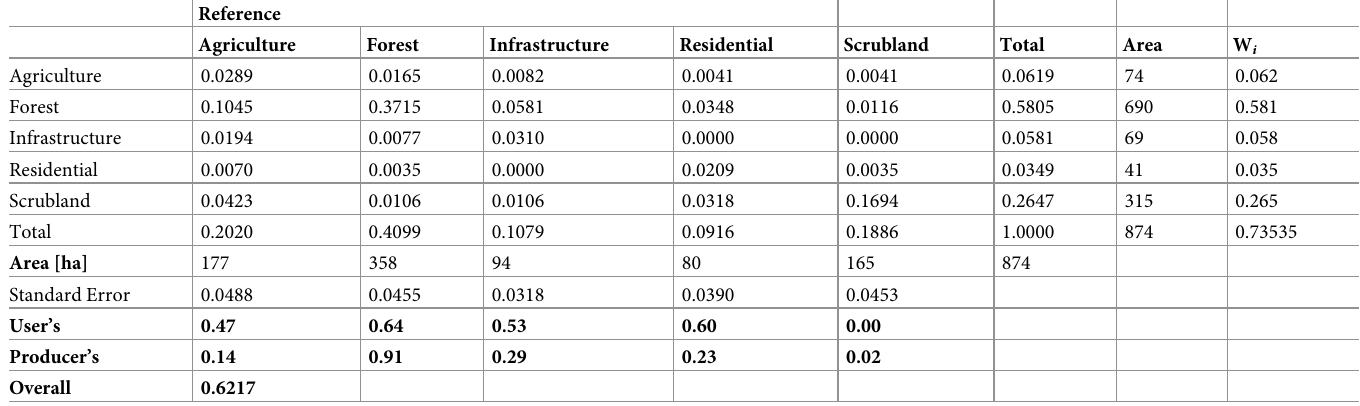
Table 4. Error matrix (area proportion) for 2010 based on stratified random